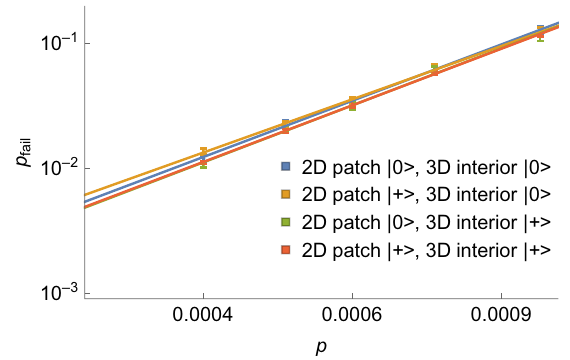
FIG. 40. The impact on the failure probability of the code- switching protocol from different choices of basis for first two steps of the protocol.